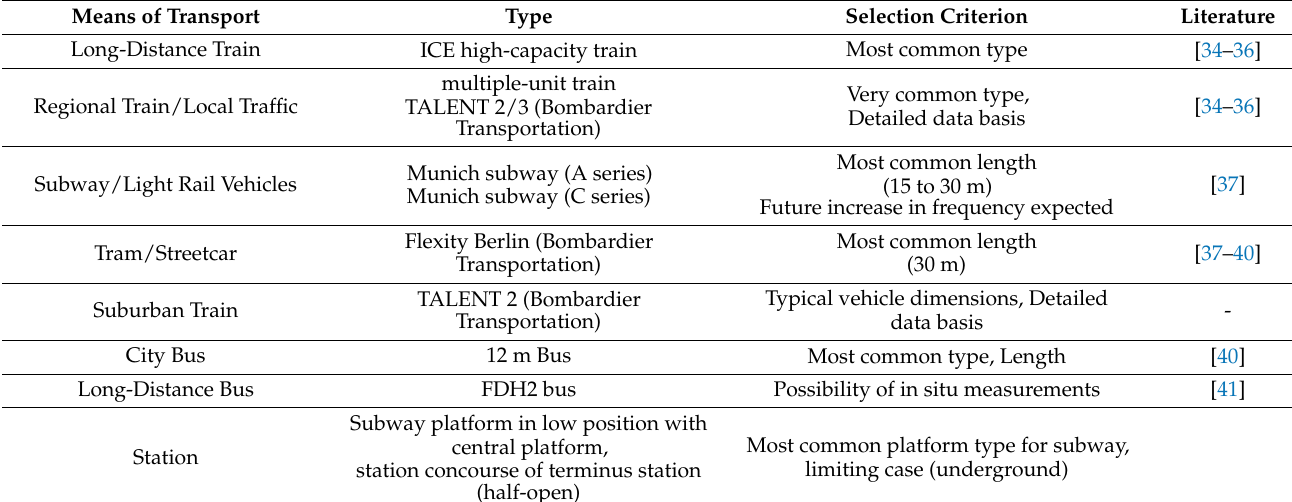
Table 3. Representative trains, buses and stations based on research and statistical